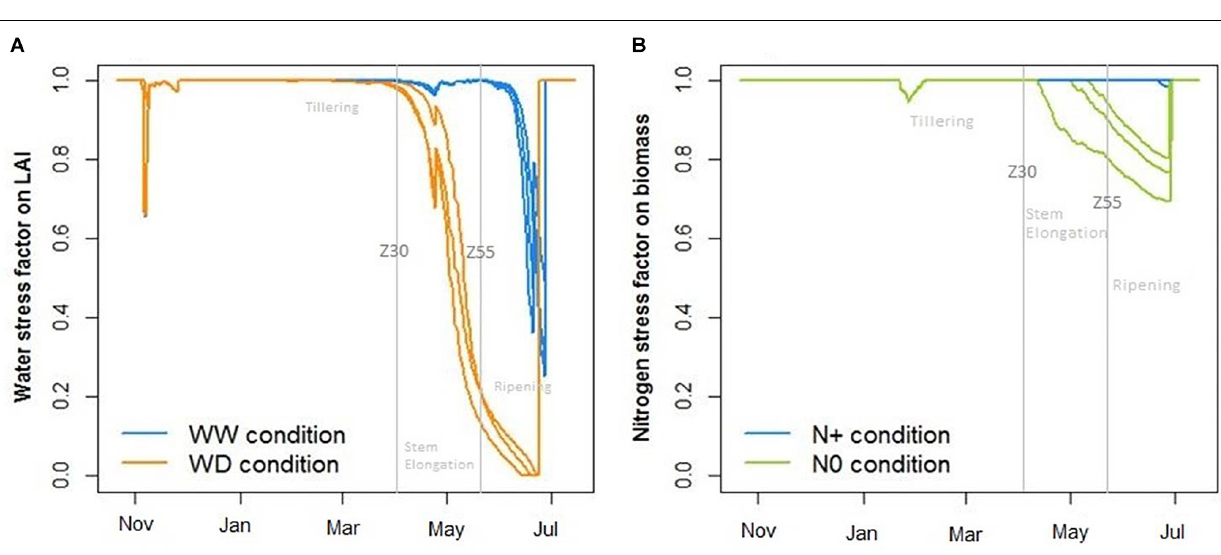
which is not significantly different from the WD N +